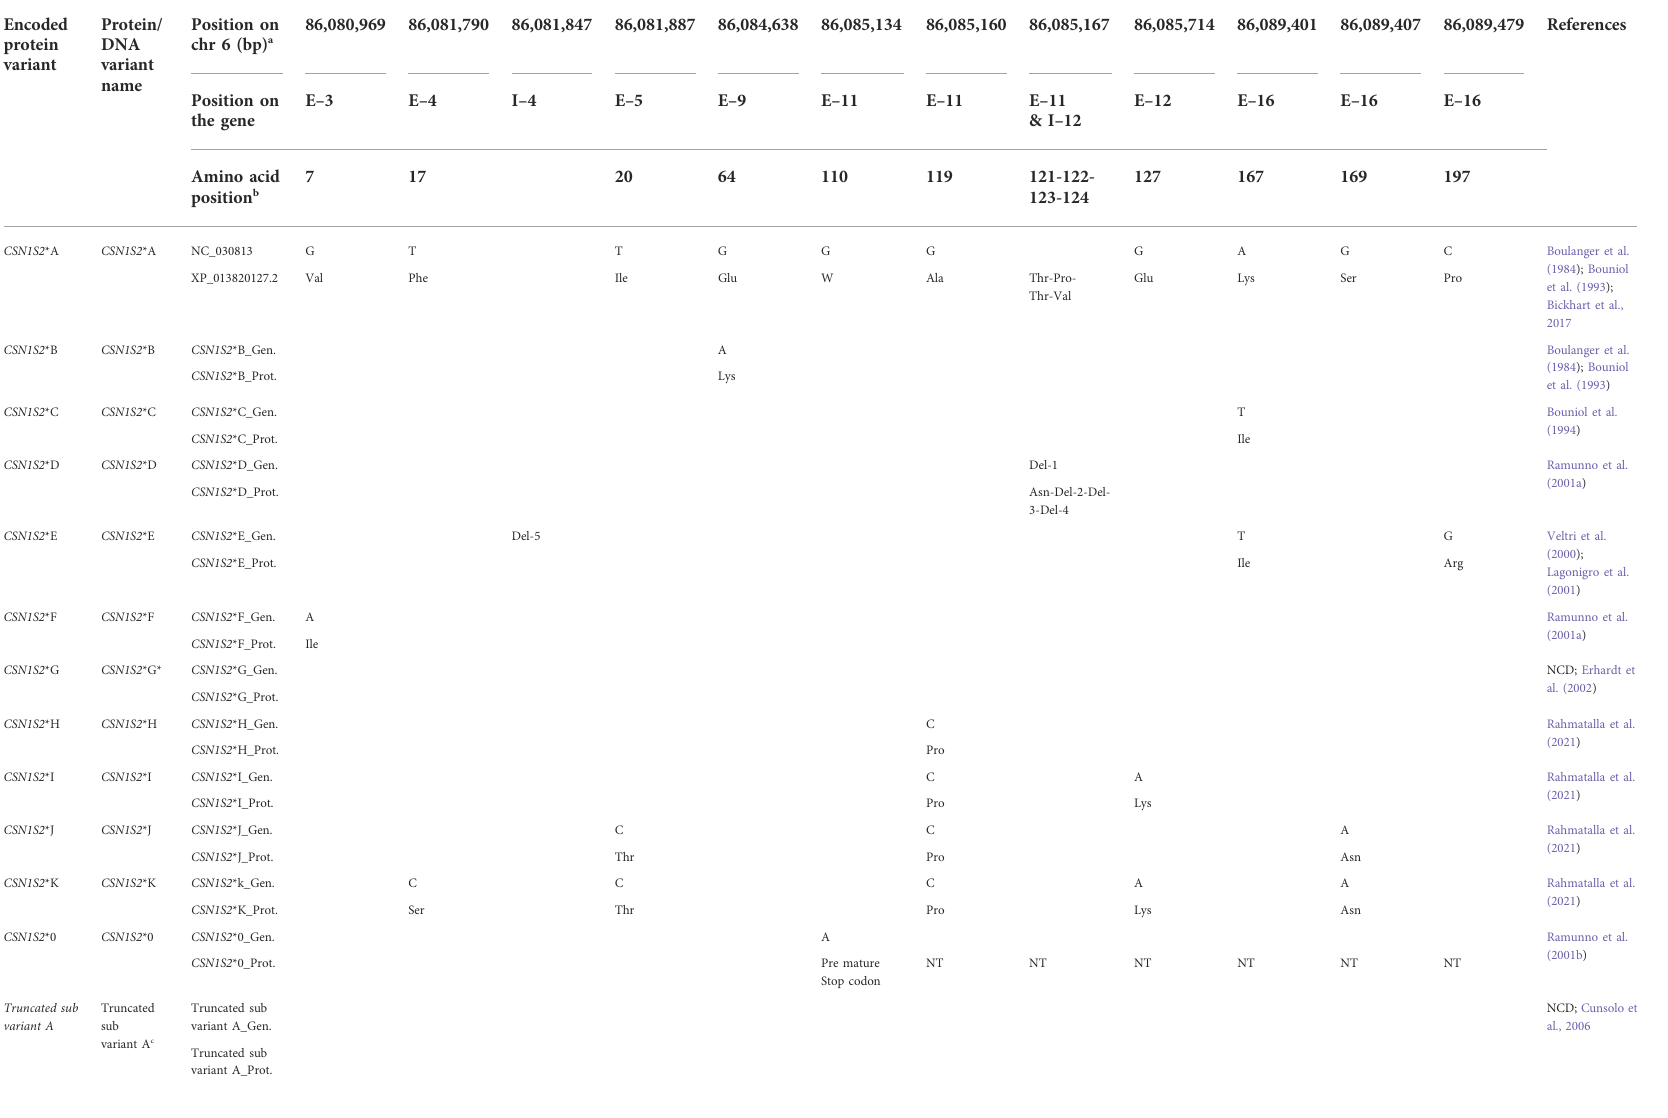
TABLE 2 Nucleotide and amino acid variants within the gene and mature protein of the CSN1S2 . Encoded